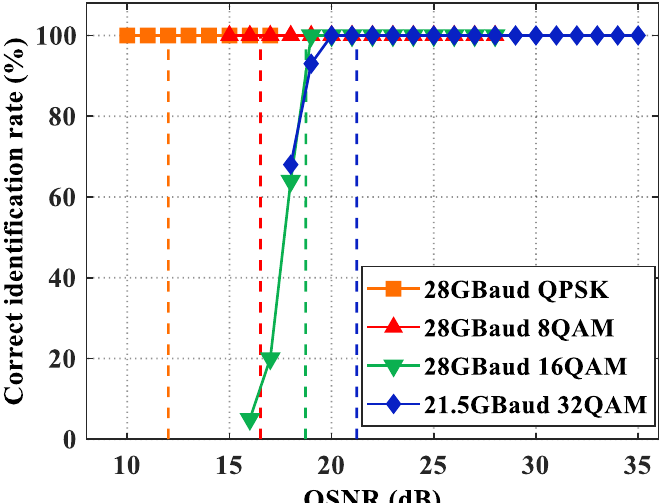
Figure 16. Correct identification rates under different OSNR values in back-to-back experiments. The vertical dash lines indicate the OSNR thresholds corresponding to 7% FEC correcting BER of 3.8 × 10 −3 .